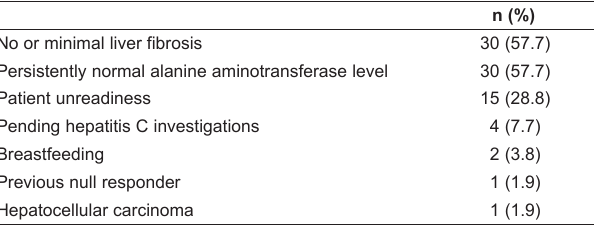
Table 3 Reasons for treatment deferral